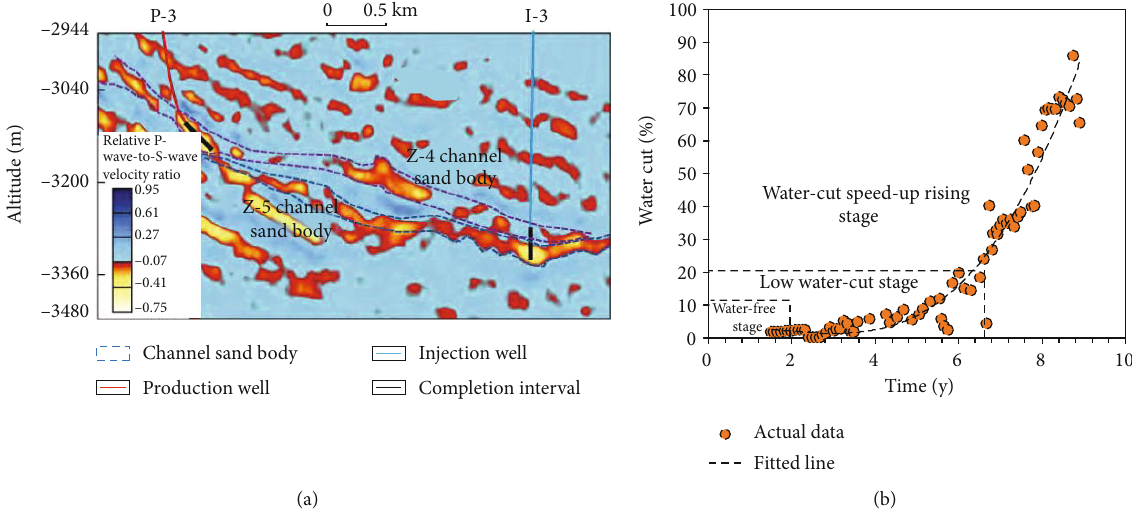
Figure 3: A typical well of Mode III: (a) seismic section image; (b) water-cut changing